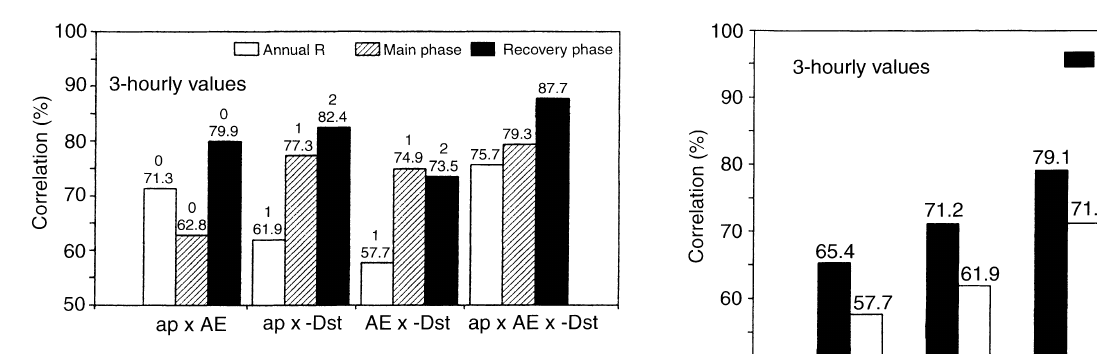
Fig. 6. Annual correlations and correlations during magnetic storm phases for 1979; Multiple correlation between ap, AE and Dst for the same period is shown in the last group. The lag of the best correlation for each case is shown on the top of each column